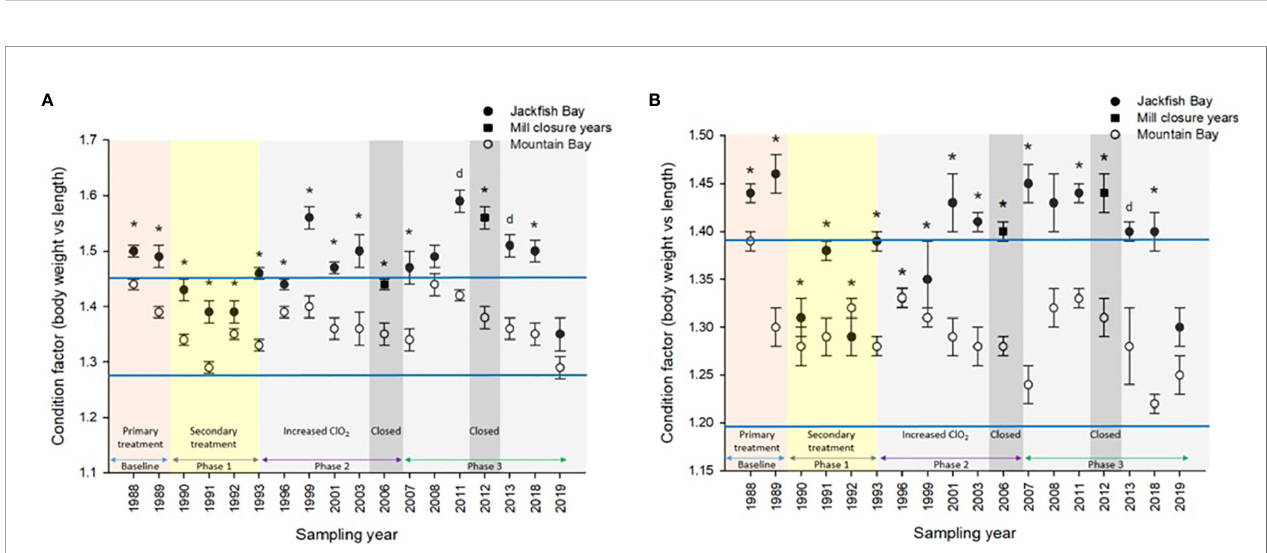
FIGURE 2 | Gonad somatic indices (± SE) of female white sucker ( Catostomus commersoni ) from Jack fi sh Bay and Mountain Bay, (A) pre-spawning (spring) and (B) early-recrudescence (fall) from 1988 to 2019. Asterisks* represent a signi fi cant difference (p ≤ 0.05) between sites within years, “ d ” represents an interaction between sites, horizontal blue bars represent the 30 year normal range for the reference site. All data before 2008 published in Bowron et al. (35).